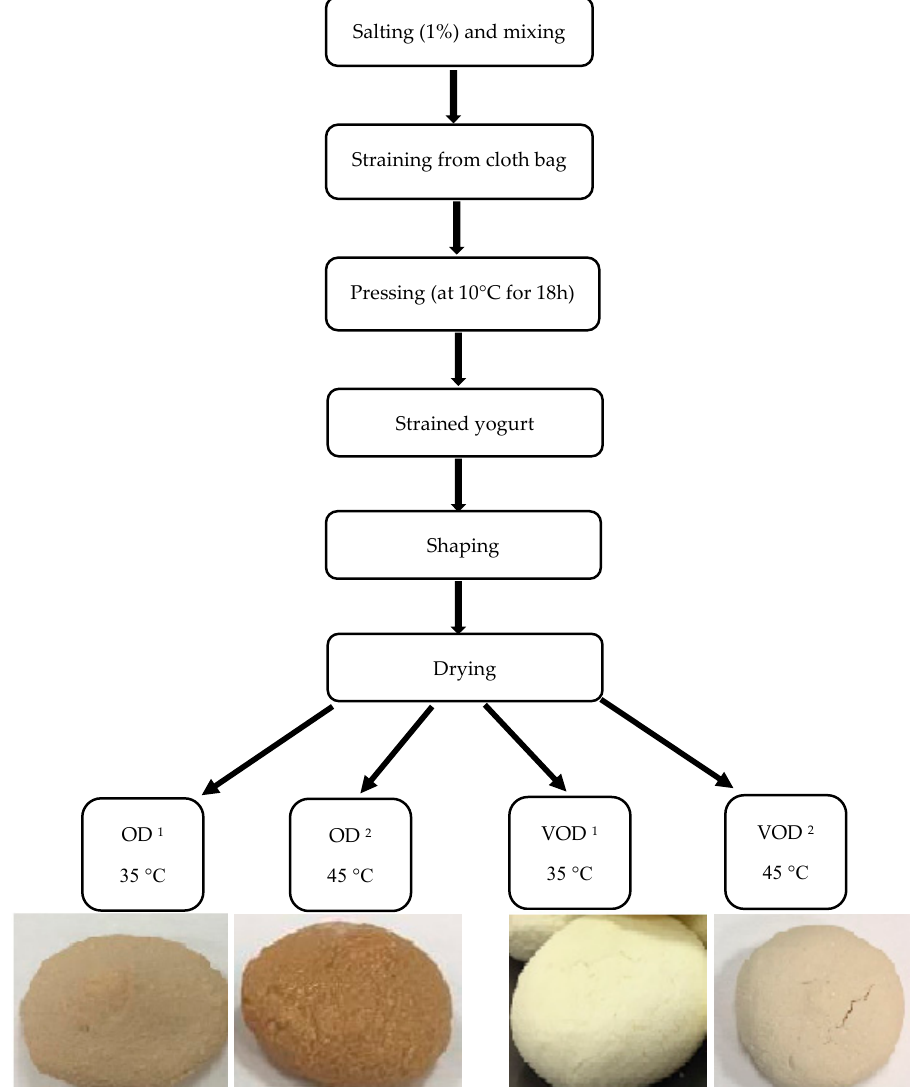
Figure 1. Strained yogurt preparation, Kurut processing and Kurut samples. OD 1 denotes oven drying technique at 35 °C; OD 2 denotes oven drying technique at 45 °C, VOD 1 denotes vacuum-assisted oven drying technique at 35 °C; VOD 2 denotes vacuum-assisted oven drying technique at 45 °C.